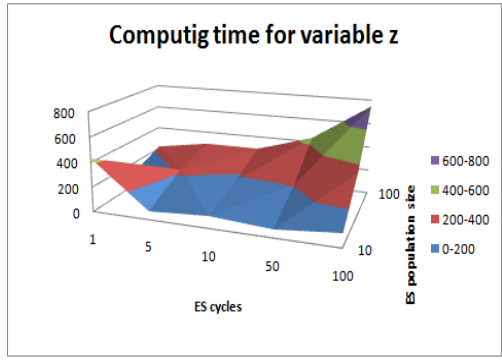
Fig. 8: Computing time of whole GPA-ES for z variable depending on ES cycle limit and ES population size.